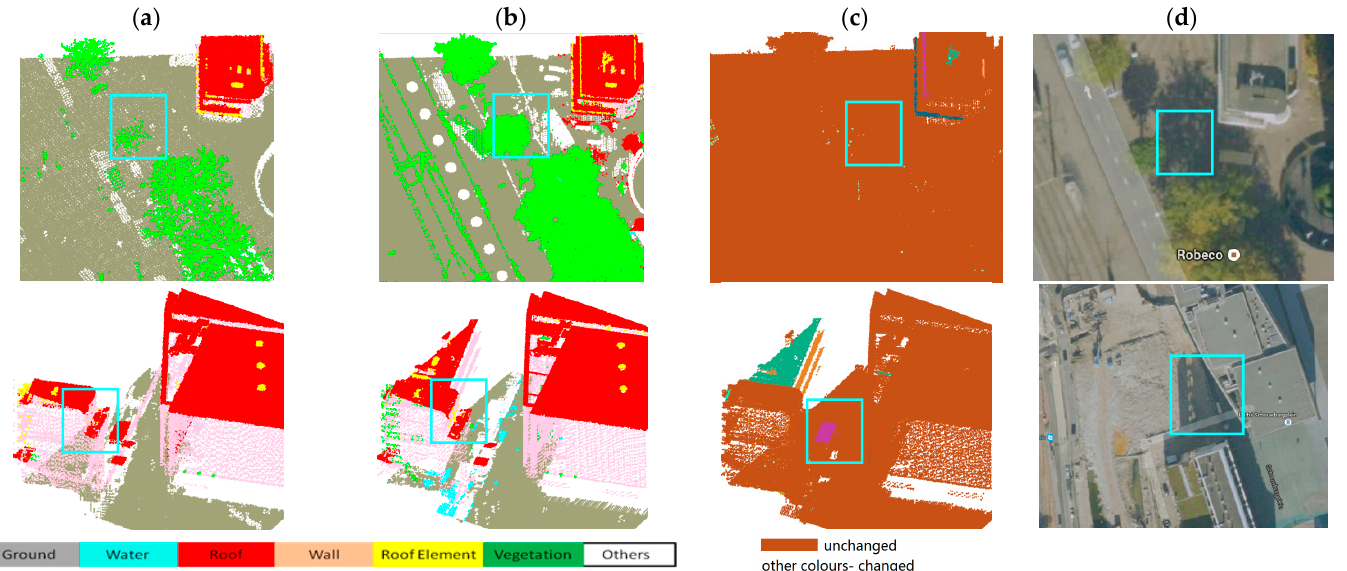
Figure 15. Examples of false negatives caused by scene classification errors. Because a building has been classified as an “undefined object” in the 2012 data set, changes to this building will not be detected (Column 3). ( a ) Data set 2010; ( b ) Data set 2012; ( c ) Change detection in building (merged); ( d ) Image from Google maps.